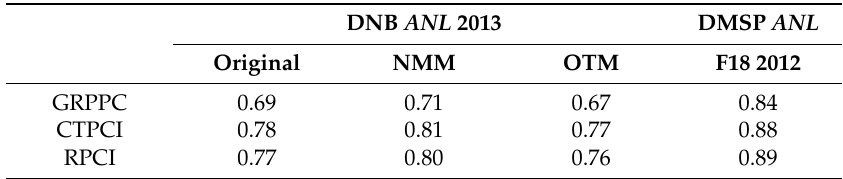
Table 6. Correlation coefficients between ANL and socio-economic parameters. ANL ’s are derived from DNB composite data with or without noise filtering and DMSP-OLS stable data, respectively.